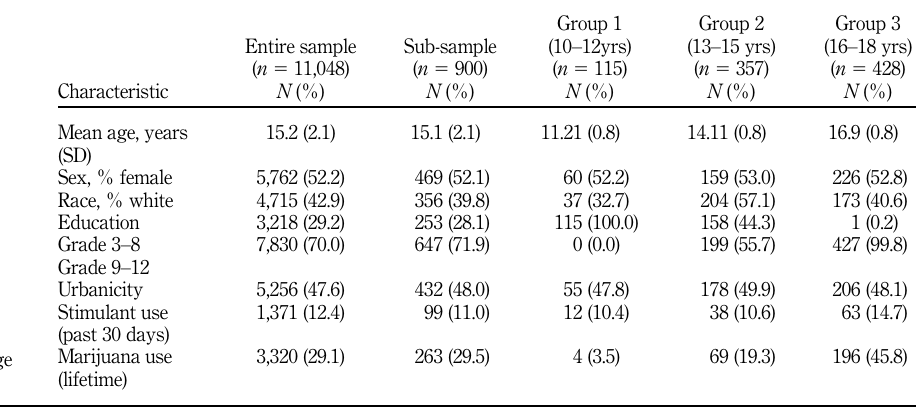
Table I. Baseline characteristics of N-MAPSS youth randomized by age group ( n 5